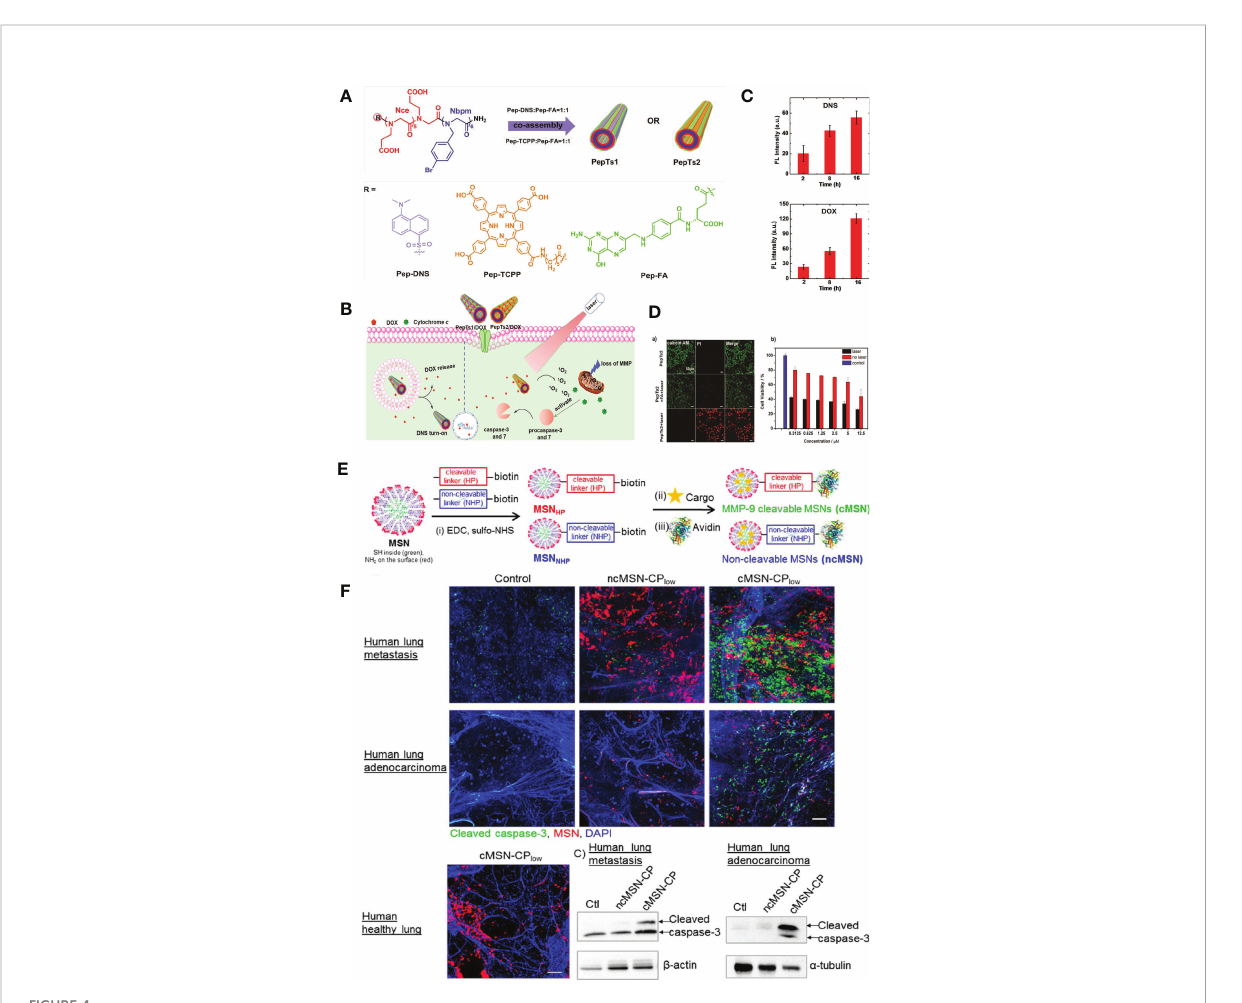
FIGURE 4 Nanotechnology boosts the effect of chemotherapy medications. (A) The structures of ligand-tagged Nbpm6Nce6 peptoid sequences and the assembly of them into 1D tubes. -R represents -Nc6TCPP, -DNS, and -FA, respectively. PepTs1 formed by Pep-FA coassembled with Pep-DNS at a ratio of 1:1. PepTs2 formed by Pep-FA coassembled with Pep-TCPP at a ratio of 1:1 (78). Adapted with permissions from ref (78). Copyright 2019, John Wiley and Sons. (B) The endocytosis process of PepTs1 as platform to deliver DOX to H1299 cells, and activation of the apoptosis pathway caused by PepTs2 in H1299 cells (78). Adapted with permissions from ref (78). Copyright 2019, John Wiley and Sons. (C) The fl uorescence intensity analysis of DOX and DNS for drug release monitoring (78). Adapted with permissions from ref (78). Copyright 2019, John Wiley and Sons. (D) Phototoxicity assessment of PepTs2 against H1299 cells. a) live/dead cell images by PI/calcein AM double staining. The laser irradiation power was 660 nm 500 mW cm − 2 for 2 min. b) MTT assay of the cytotoxicity of PepTs2/DOX against H1299 cells with/without irradiation at power of 500 mW cm − 2 for 5 min (78). Adapted with permissions from ref (78). Copyright 2019, John Wiley and Sons. (E) Synthesis scheme of core (green, thiol groups), shell (red, amino groups) functionalized MSNs. (i) EDC amidation of amino groups with carboxy groups of the MMP9 cleavable HP (HP, red) or the MMP9 noncleavable HP-biotin linker (NHP, blue) results in a covalent attachment to the external particle surface (MSNHP, MSNNHP). (ii) After cargo incorporation (cisplatin (CP) or bortezomib combination treatment (CT), yellow star), (iii) the strong binding af fi nity of biotin to avidin leads to blocking of the mesopores of MSNs with MMP9 cleavable linkers (cMSN) and MMP9 noncleavable linkers (ncMSN) (79). Adapted with permissions from ref (79). Copyright 2015, American Chemical Society. (F) Therapeutic effect of MMP9-responsive MSNs in human lungs. Human lung adenocarcinoma and humanhealthy lung 3D-LTC exposed to cMSN-CPlow or ncMSN- CPlow for 72 h. Nonexposed control slices were included in the study.Nuclear staining (DAPI, blue), cleaved caspase-3 (green), and MSNs (red). The scale bar is 50 m m. Images shown are representative for three different sections within the tumor. Western blot analysis of human 3D-LTC exposed to cMSN-CPlow and ncMSN-CPlow for 72 h is also shown in the fi gure (79). Adapted with permissions from ref (79). Copyright 2015, American Chemical